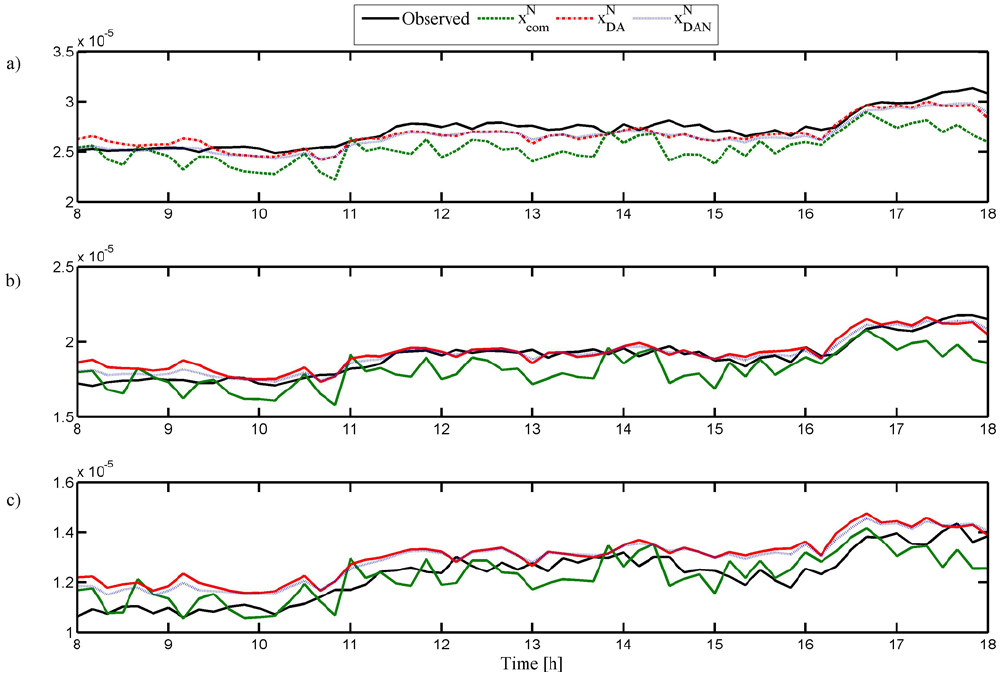
Fig. 5. The observed scattering ( σ obs ; black, solid), the scattering calculated from x N dotted) and from x N com ( σ com ; green, dashed) for wavelengths 450, 550 and 700nm ( a , b and c ,